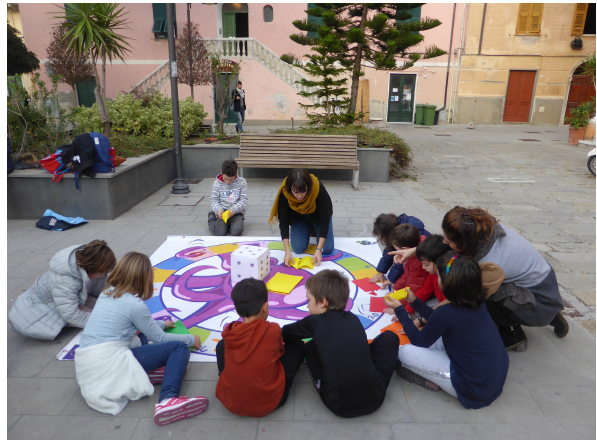
Figure 3. A group of students play the Octopus game with a INGV researcher (“conductor” of the game), during an outreach event in the city of Monterosso (La